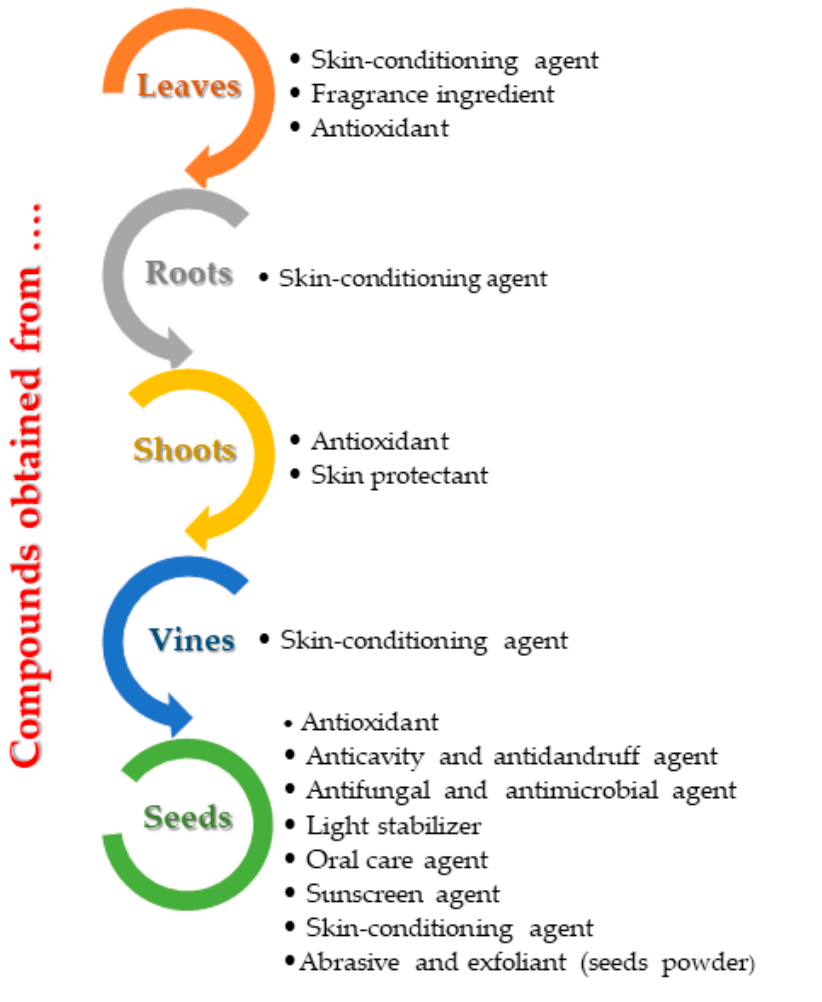
Figure 4. The main applications of bioactive compounds obtained from grapevine waste extracts in cosmetic formulations.